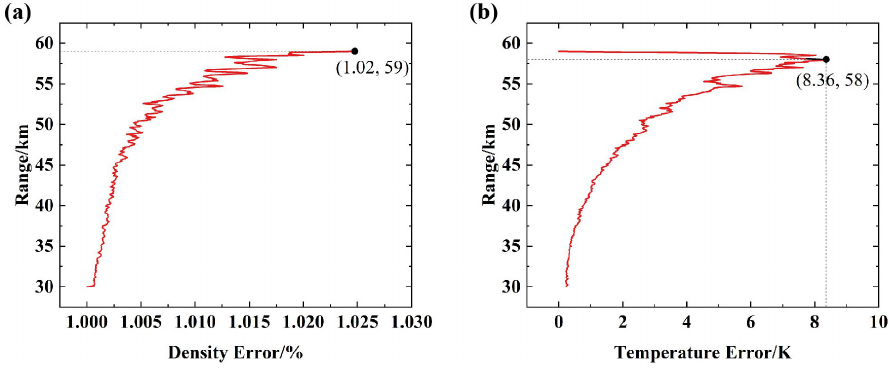
Figure 4. The absolute error of ( a ) density and ( b ) temperature retrieval with the WT method. It should be noted that the calculation of the SNR here is different from the previous one, due to the ideal signal not being able to be acquired in actual measurement. Con- sidering the statistical properties of the detector, the SNR under Poisson distribution is defined as the ratio of the target backscatter echo signal to the square root of the original echo signal, where the original echo signal includes the target backscatter echo signal and the background noise. Usually, after a certain distance, the background counts of the lidar do not change with height, then it is considered that the photon counts collected by lidar is only the background noise. Thus, the average value of the photon counts after the certain distance can be taken as the background noise. The expression of SNR m is as follows: